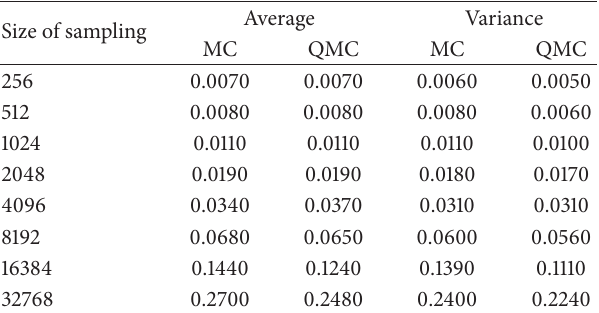
Table 19: Computational cost of computation of statistics of CIR interest rate model 𝑅 𝑇 at 𝑇 = 1 , determined by MC, QMC, with = 110 . 𝛼 = 0.1 , 𝛽 = 0.002 , 𝜎 = 15 %, and 𝑅 0